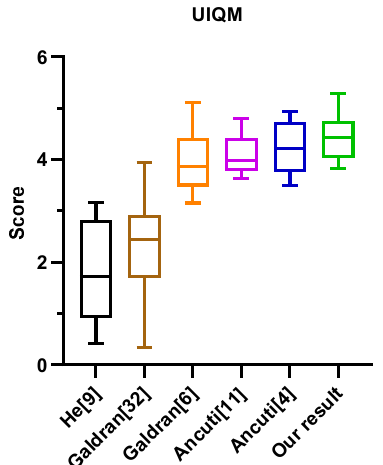
Figure 11. Robustness of the UIQM metric.